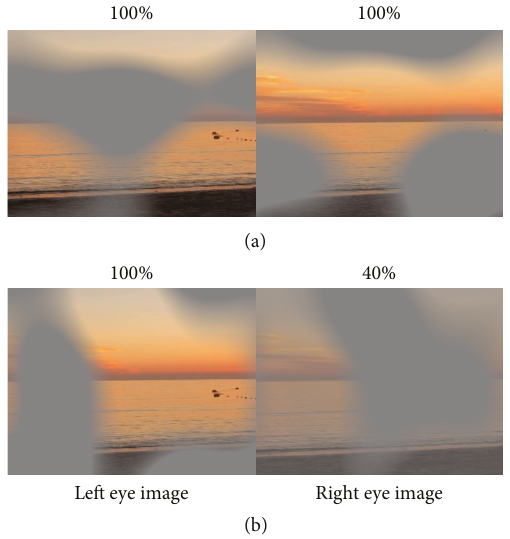
Figure 1: Illustration of the dichoptic movies. The two eyes ’ views are shown side by side. Complementary patterned image masks composed of irregularly shaped blobs were overlaid over the images seen by the two eyes. The shape and location of the blobs were varied dynamically every 10 seconds. (a) 100% contrast images were presented to the two eyes. (b) A 100% contrast image is presented to the left eye, and an image with a contrast reduced to 40% is presented to the right eye. Movie examples are available as supplementary material. Source video: Lauren Sauvan, wikimedia